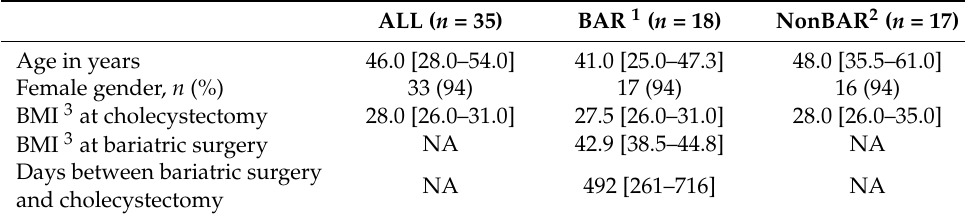
Table 1. Patient